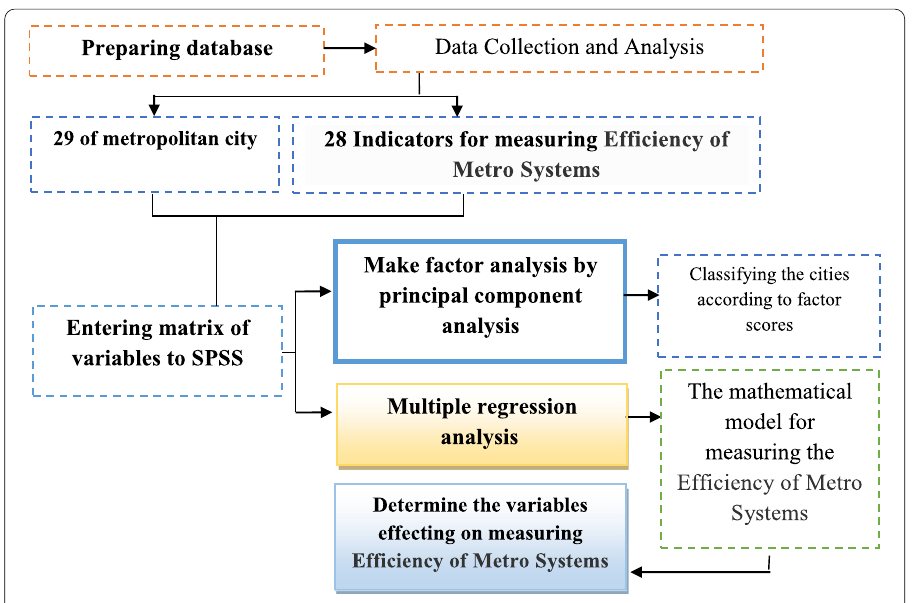
Fig. 3 The methodology steps for analytical and applied